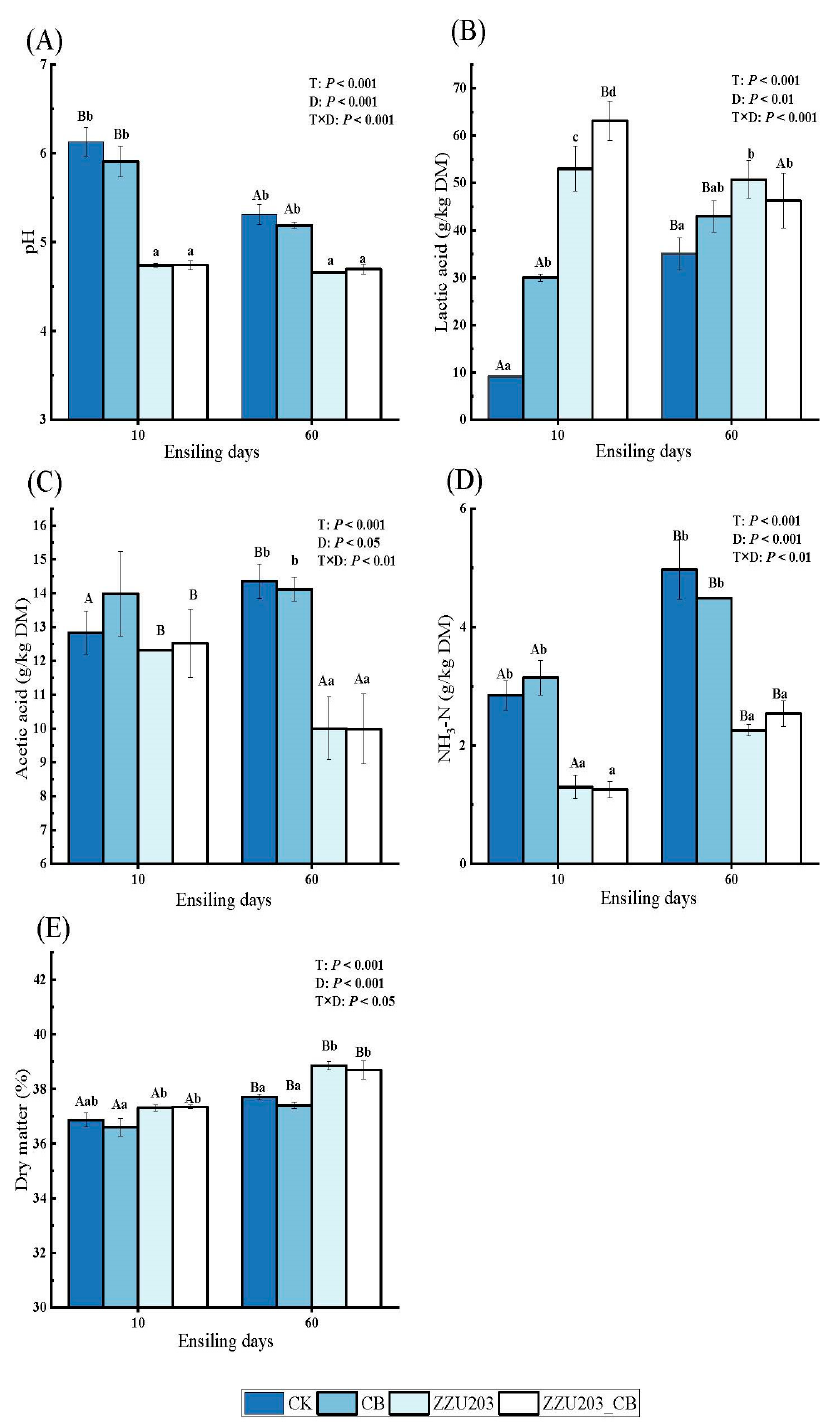
Figure 1. Changes in pH ( A ), Lactic acid (LA) ( B ), Acetic acid (AA) ( C ), NH 3 -N ( D ) and Dry matter (DM) ( E ) in alfalfa silages during ensiling for 60 d. Values with different superscript lowercase letters show significant differences between treatments on the same ensiling day, while values with different superscript capital letters show significant differences between ensiling days with the same treatment ( p < 0.05). NH 3 -N, ammoniacal nitrogen.